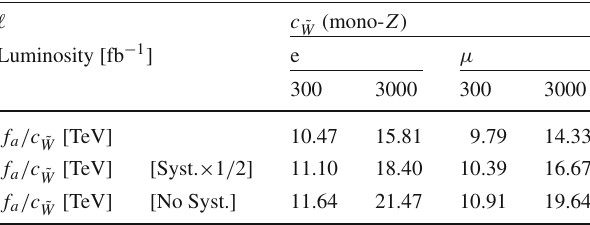
Table 4 Projected 95% CL f a / c i reach at LHC, with L = 300fb − 1 = ( c ˜ / f ) 2 from mono- Z production, as and L = 3000 fb − 1 for μ ˜ a W W detailed in Sect. 6.3.2. Top row: Assuming future systematic uncertain- ties on the background scale as present ones. Middle row: Assuming systematic uncertainties are reduced by a factor 2 w.r.t. present ones. Bottom row: Assuming no background systematic uncertainties